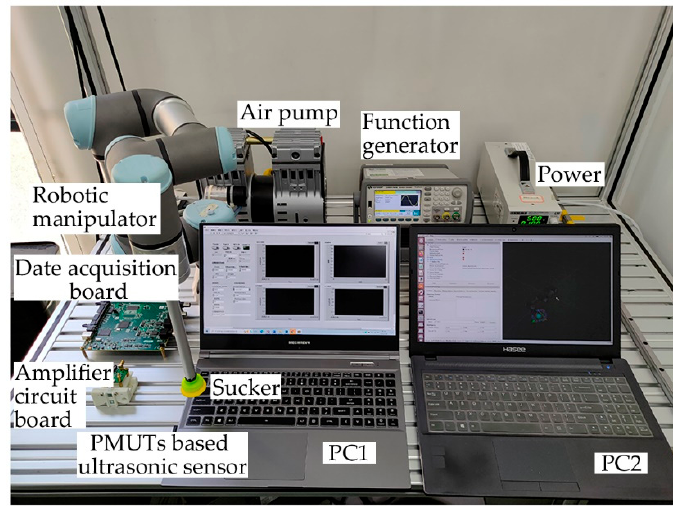
Figure 8. The devices of the comprehensive